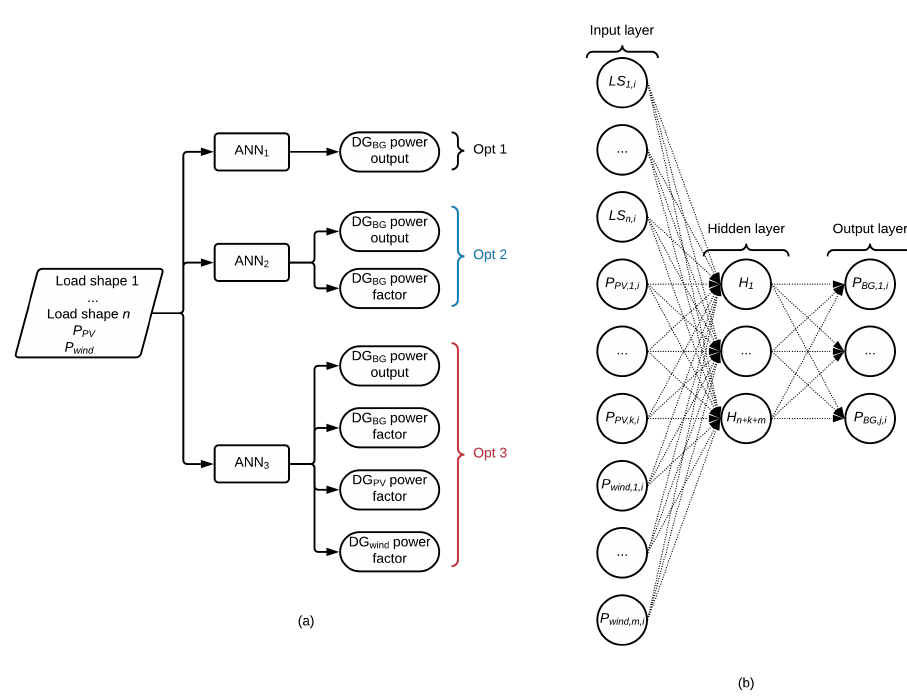
Figure 4. ( a ) Overview of data types used by the ANN; ( b ) schematic structure of the